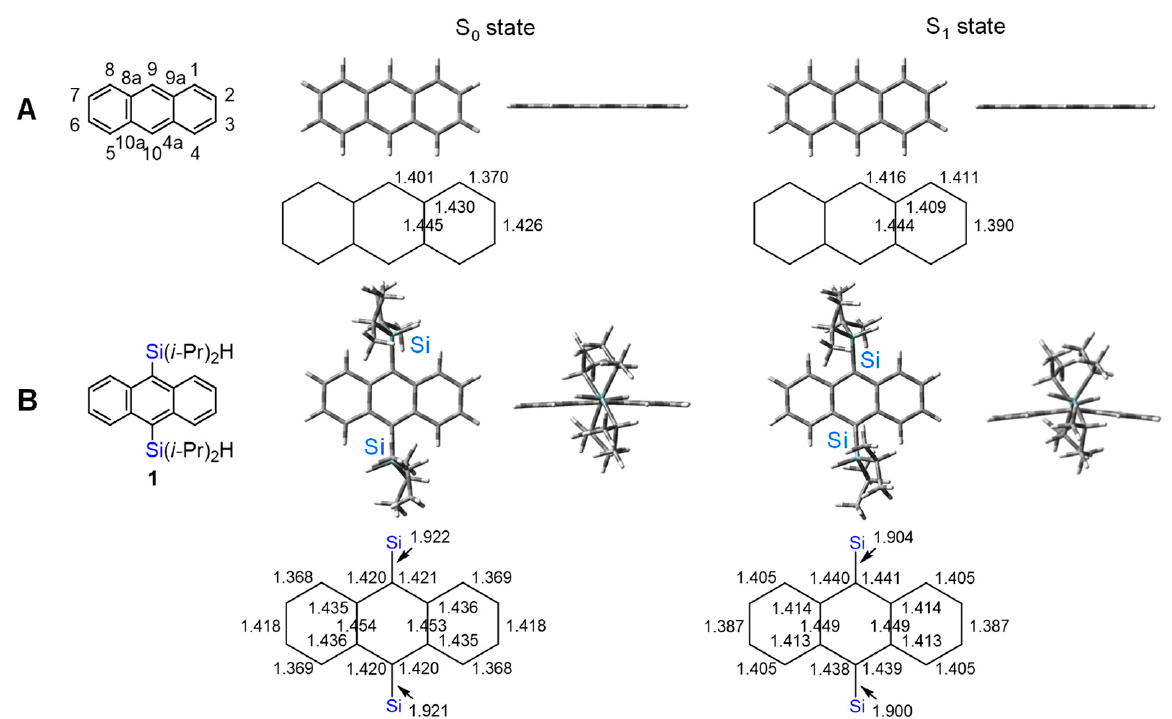
Figure 7. Top and side views and bond lengths (Å) of the optimized structures of the S 0 and S 1 states of 1 ( B ) and anthracene ( A ). The structures of the S 0 and S 1 states were calculated at the B3LYP/6-31G(d) and TD-DFT B3LYP/6-31G(d) levels, respectively.